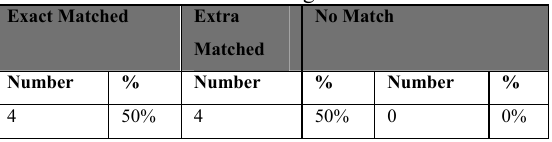
Table 7: Domain experts matching compared with TEKM